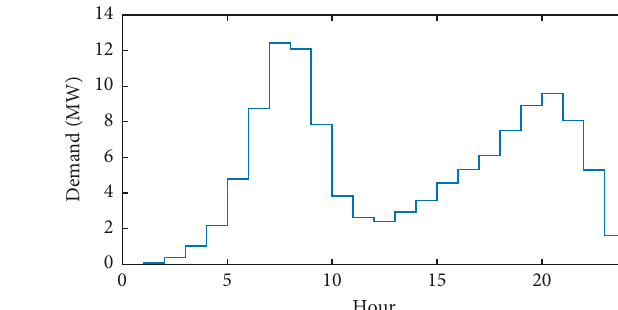
Figure 6: Wind speed at the wind farm.